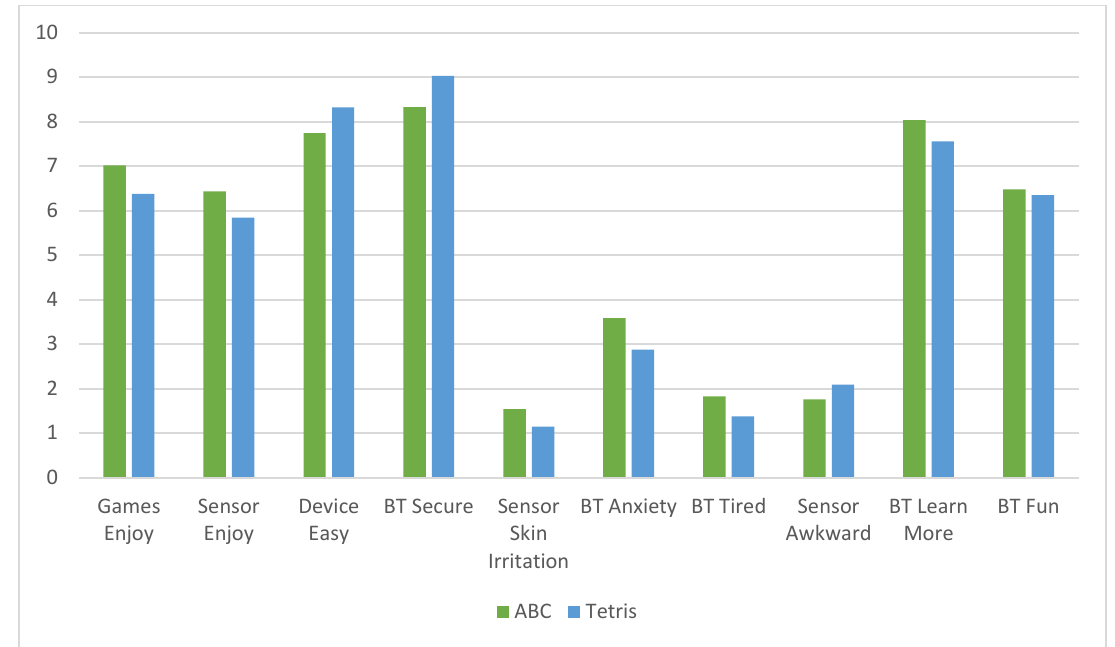
Figure 2. Cognitive training user-experience satisfaction ratings by group. Satisfaction ratings scored on a 10-point scale with 1 = low satisfaction and 10 = high satisfaction. Mean satisfaction was high for both the ABC (M = 7.93, SD = 1.17) and Tetris (M = 8.00, SD = 1.18) cognitive training groups.